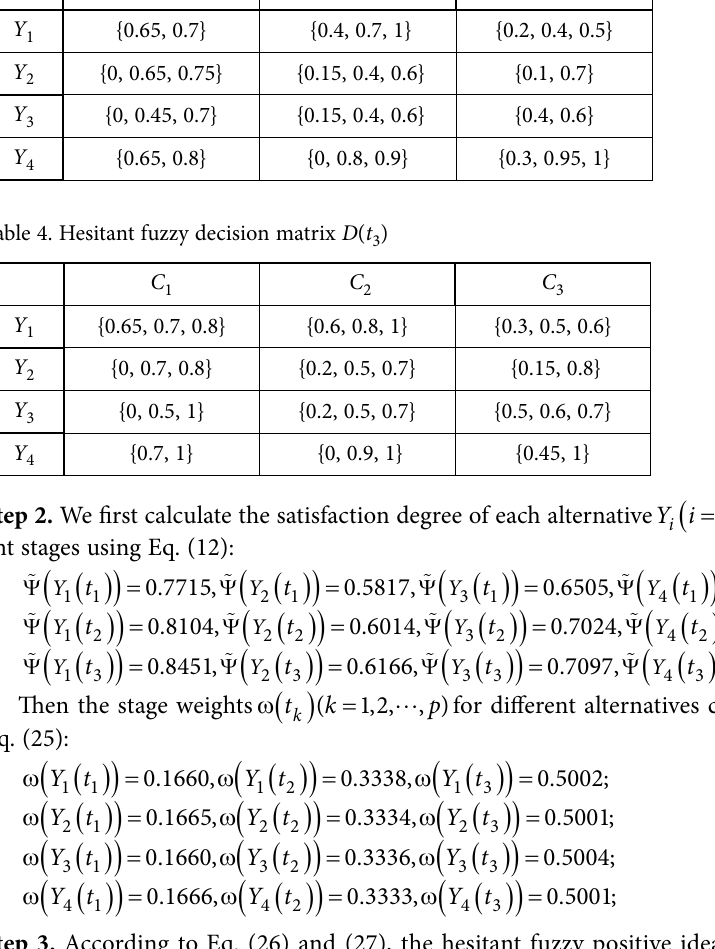
Table 3. Hesitant fuzzy decision matrix D ( t C 1 C 2 C 3 Y 1 {0.65, 0.7}